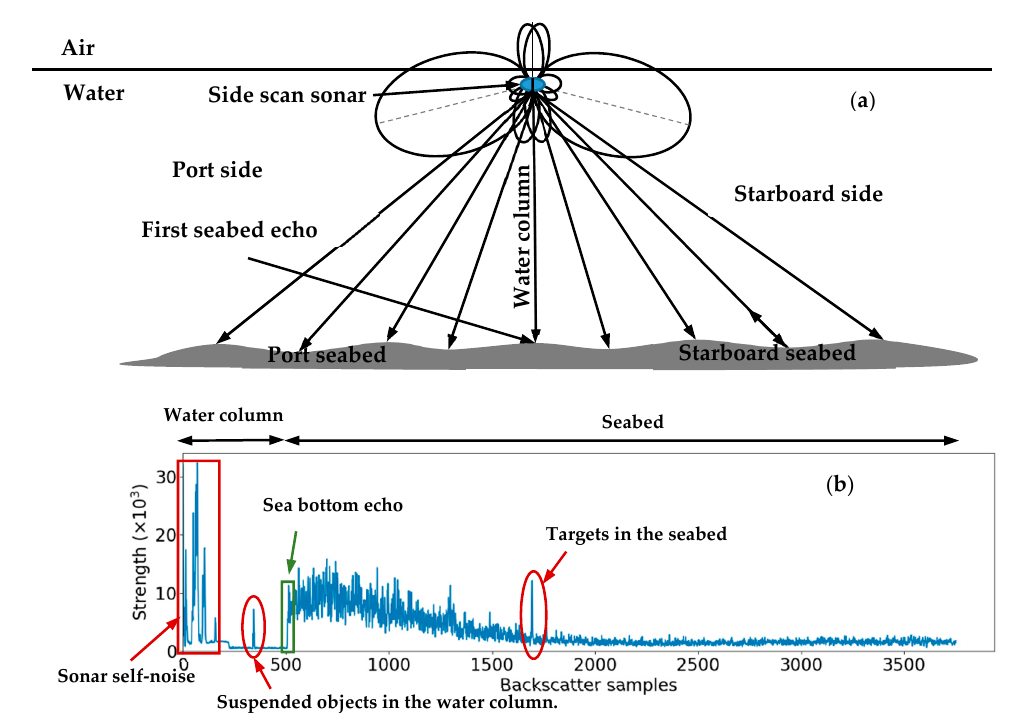
Figure 1. Operation and one-ping port-side (starboard-side) backscatter strength sequence of the side-scan sonar. ( a ) shows the beam pattern and the sound propagation of a side-scan sonar; ( b ) shows a backscatter strength sequence of a port-side (starboard-side) ping affected by many factors.